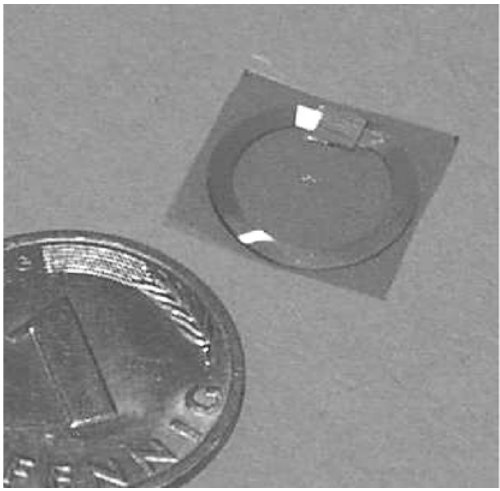
FIGURE 6 Transponder with transmission coil. ( #